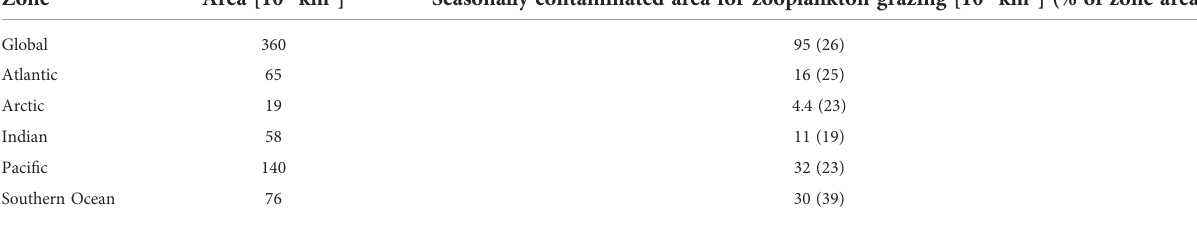
This table indicates the ocean surface area (globally and in each ocean) where the seasonal maximum MP concentration and zooplankton grazing activity coincide. Numbers between brackets indicate the percentage of each zone that is seasonally contaminated by microplastics